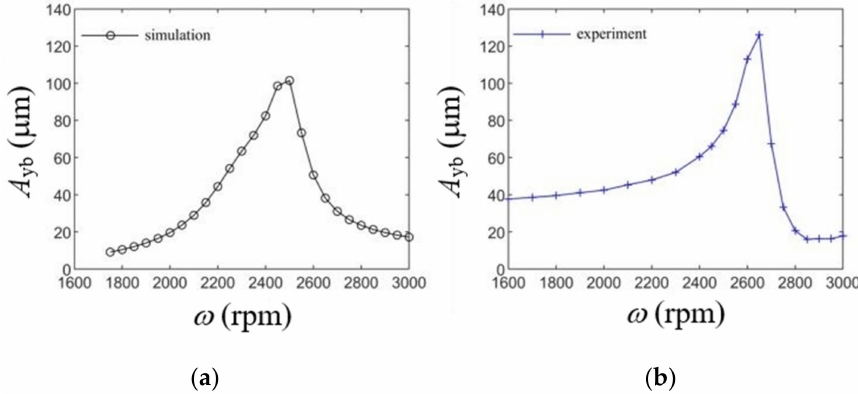
Figure 18. Test vibration amplitude of the imprecise rod–disk rotor bearing system. ( a ) Simulation result; ( b ) Experimental result.